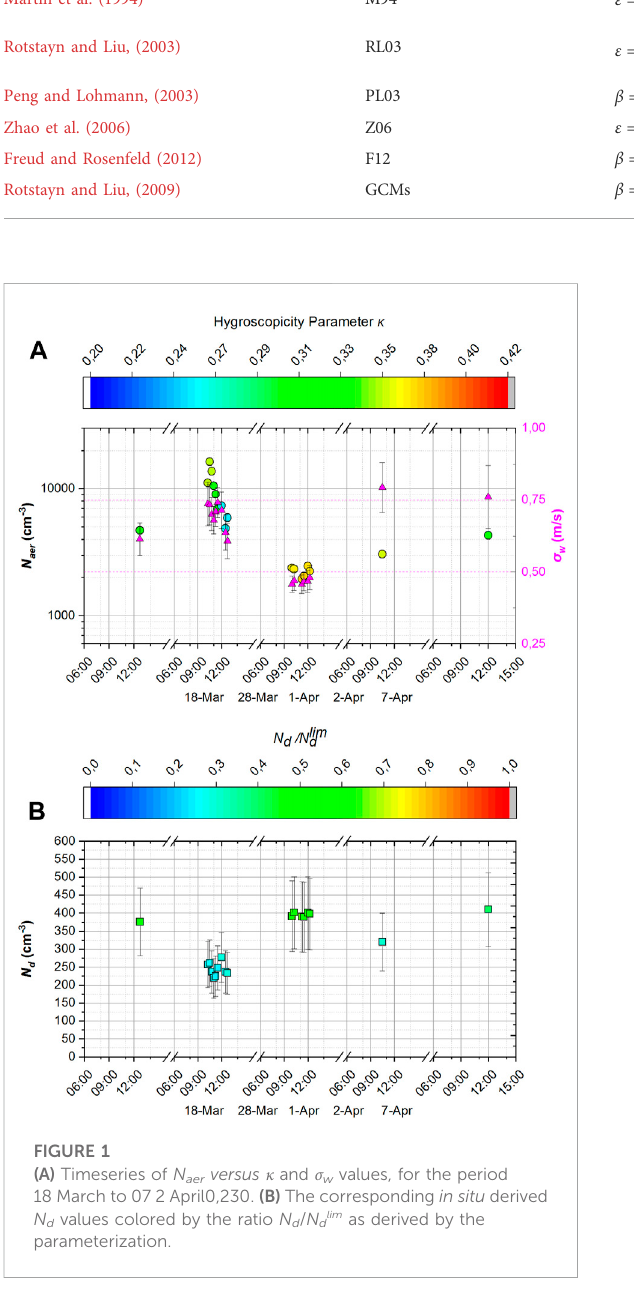
distributions, and σ w , with the symbols colored by κ , for the